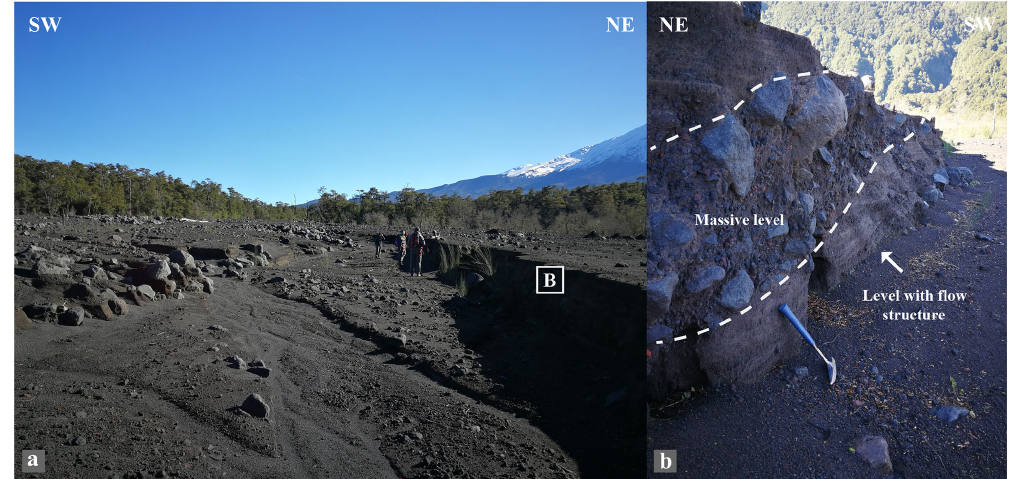
Figure 8. (a) Distal zone in an alluvial deposit in the El Solitario sector. (b) Alluvial deposit with thickness of 1.2m; the base level presents flow structures with fluvial